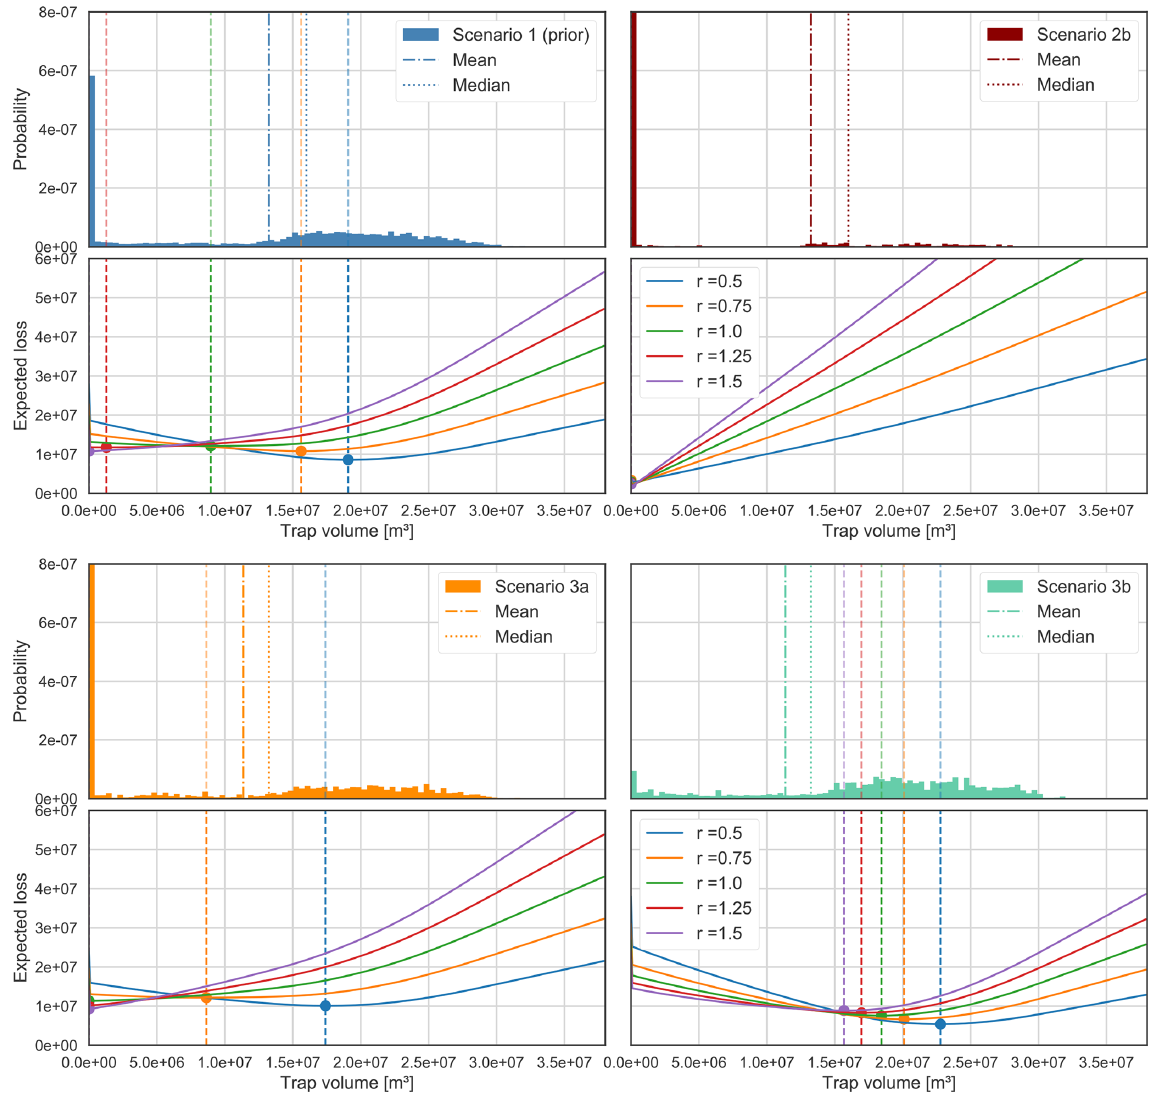
Figure B1. Posterior trap volume distributions and respective loss function realization plots for Scenarios 1 (prior), 2b, 3a, and